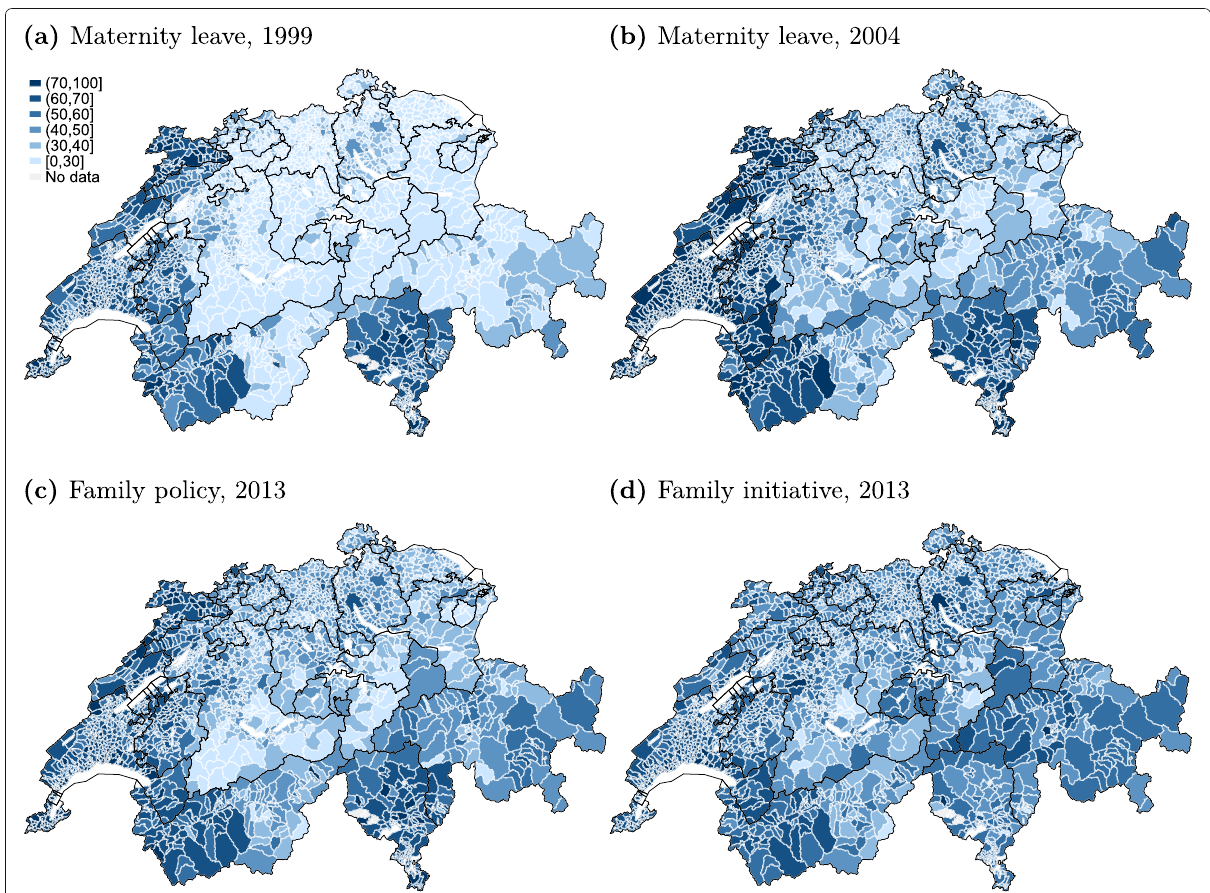
Fig. 1 The graphs show average approval rates for each municipality in Switzerland and for the four bills on policies promoting maternal employment considered in this analysis. White lines mark municipality borders; black lines mark cantonal borders. Light blue areas indicate low approval rates and dark blue areas indicate high approval rates